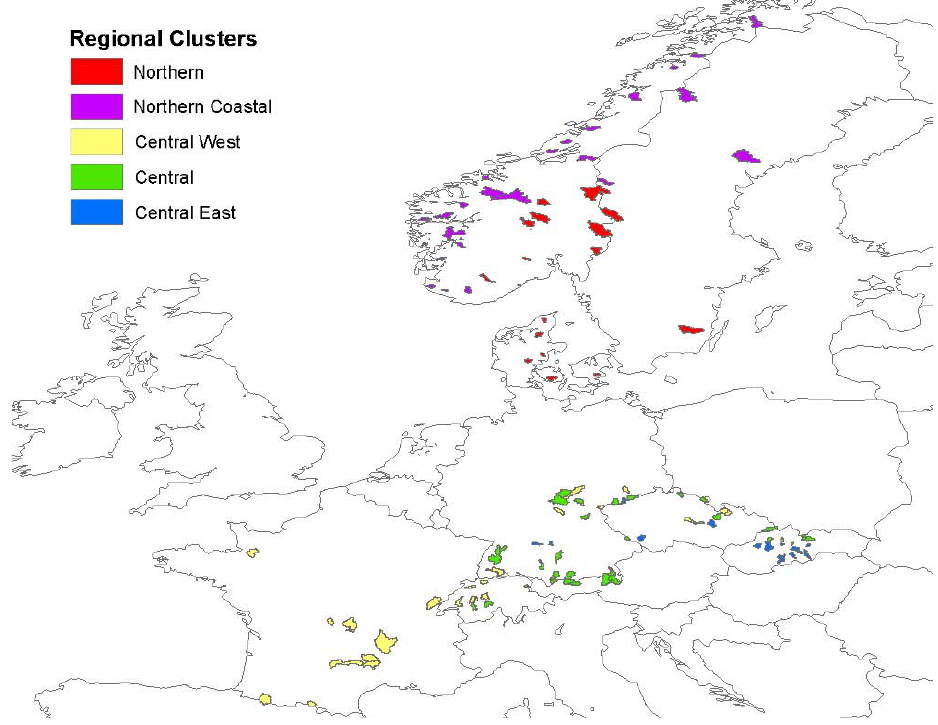
Fig. 2. Location of the catchments used, grouped into the five homogeneous regions used in this study.